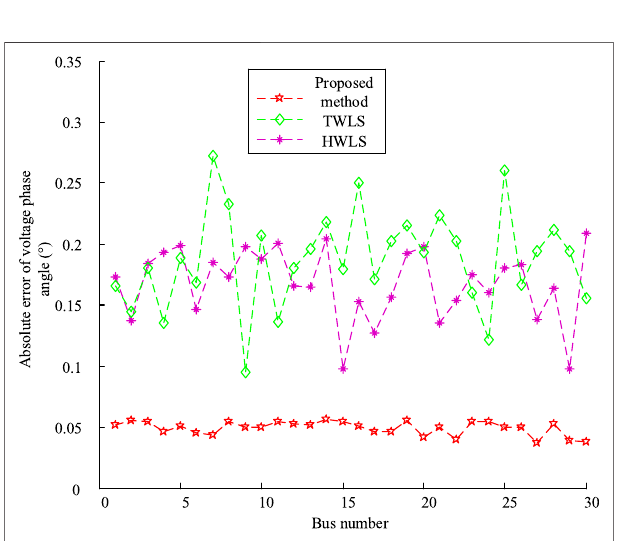
FIGURE 8 | The absolute error of the voltage amplitude under different cases.